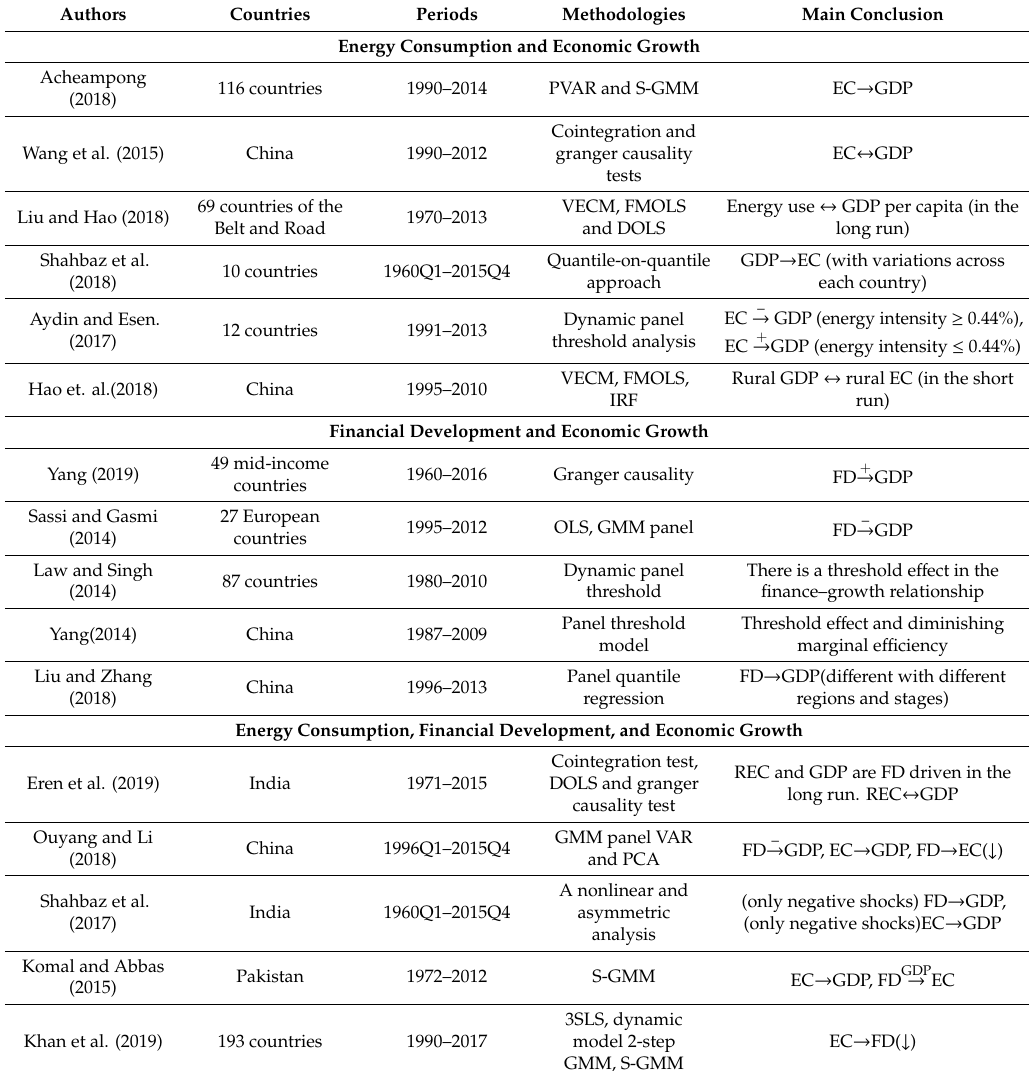
Table A1. Summary of the existing empirical studies.